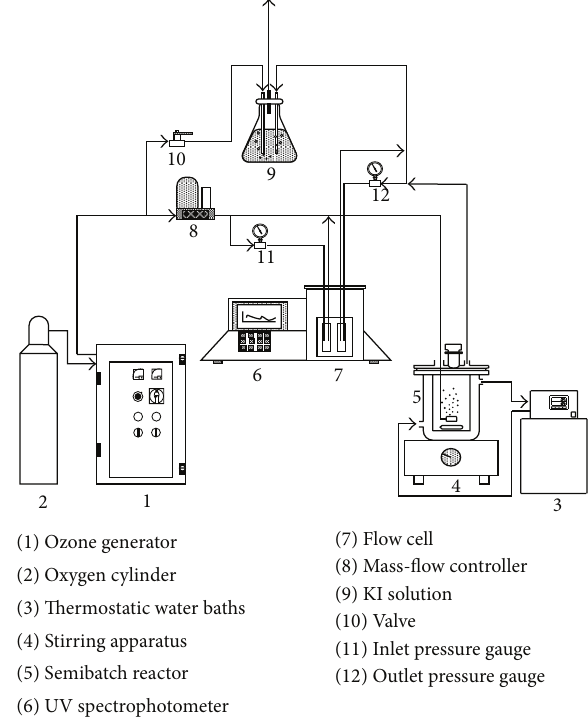
Figure 1: Experimental setup of the ozonation